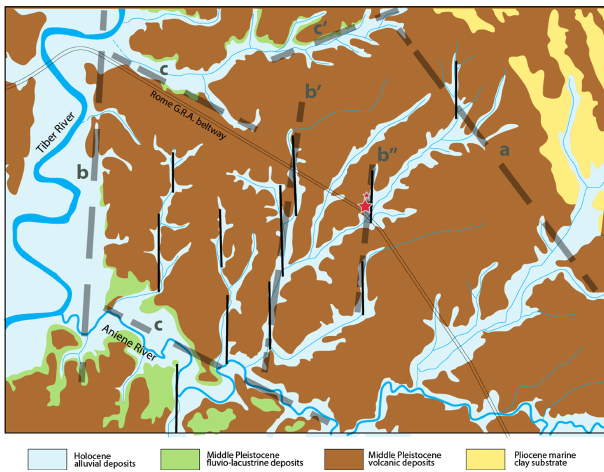
Figure 9. Geo-morphostructural setting of the epicenter area. The thicker dashed lines represent the main buried faults inferred from the analysis of the hydrographic network, with the exception of the “a” fault, interpreted on the basis of the presence of a structural high to the NE, represented by outcrops of Pliocene sediments. A fourth set of NE–SW lineaments is likely originated by the topographic gradient in this area and is not highlighted as a potential structural control. The thin, solid lines represent the superficial expression of the deformation linked to faults that are continuous at depth (b’, b”), evidenced by straight tracts of the riverbeds. One of these deep NNE–SSW faults is the one that generated the 11 May earthquake, as the focal mechanism of this event